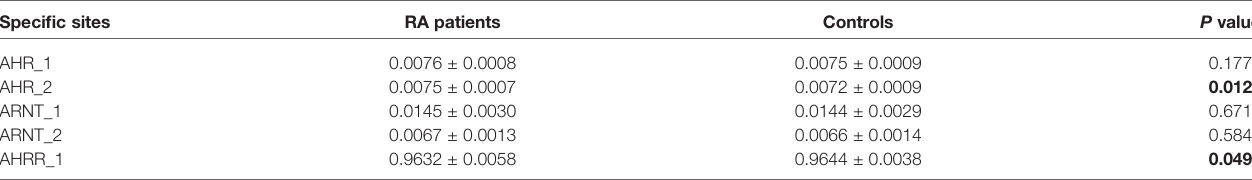
TABLE 5 | Methylation levels of speci fi c sites between RA patients and controls. Speci fi c sites RA patients Controls P value